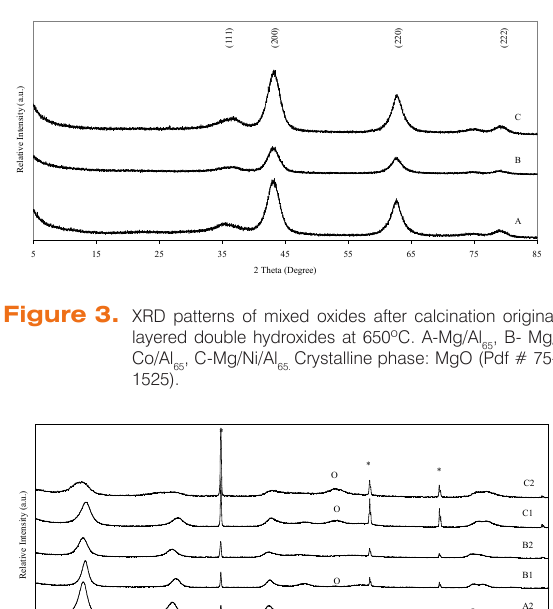
Figure 4. XRD patterns of reconstituted layered double